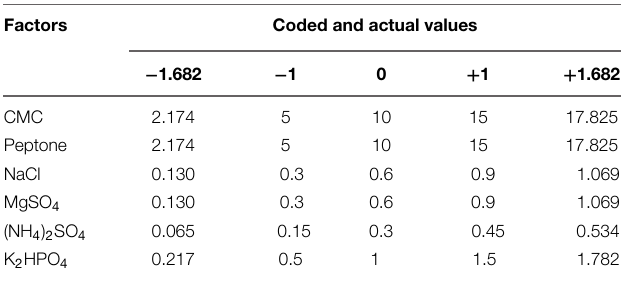
TABLE 1 | Factors involved according to CCD in RSM for optimization of cellulase